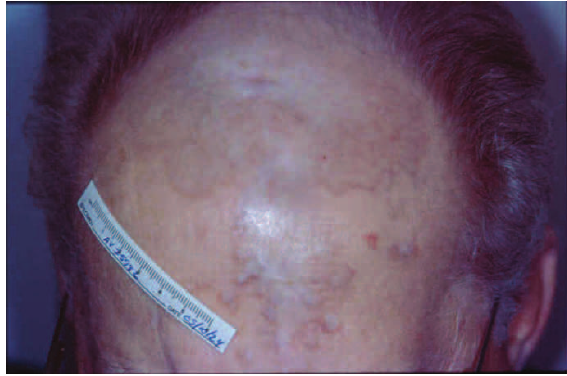
Figure 3. Sustained complete response 46 months post treatment.